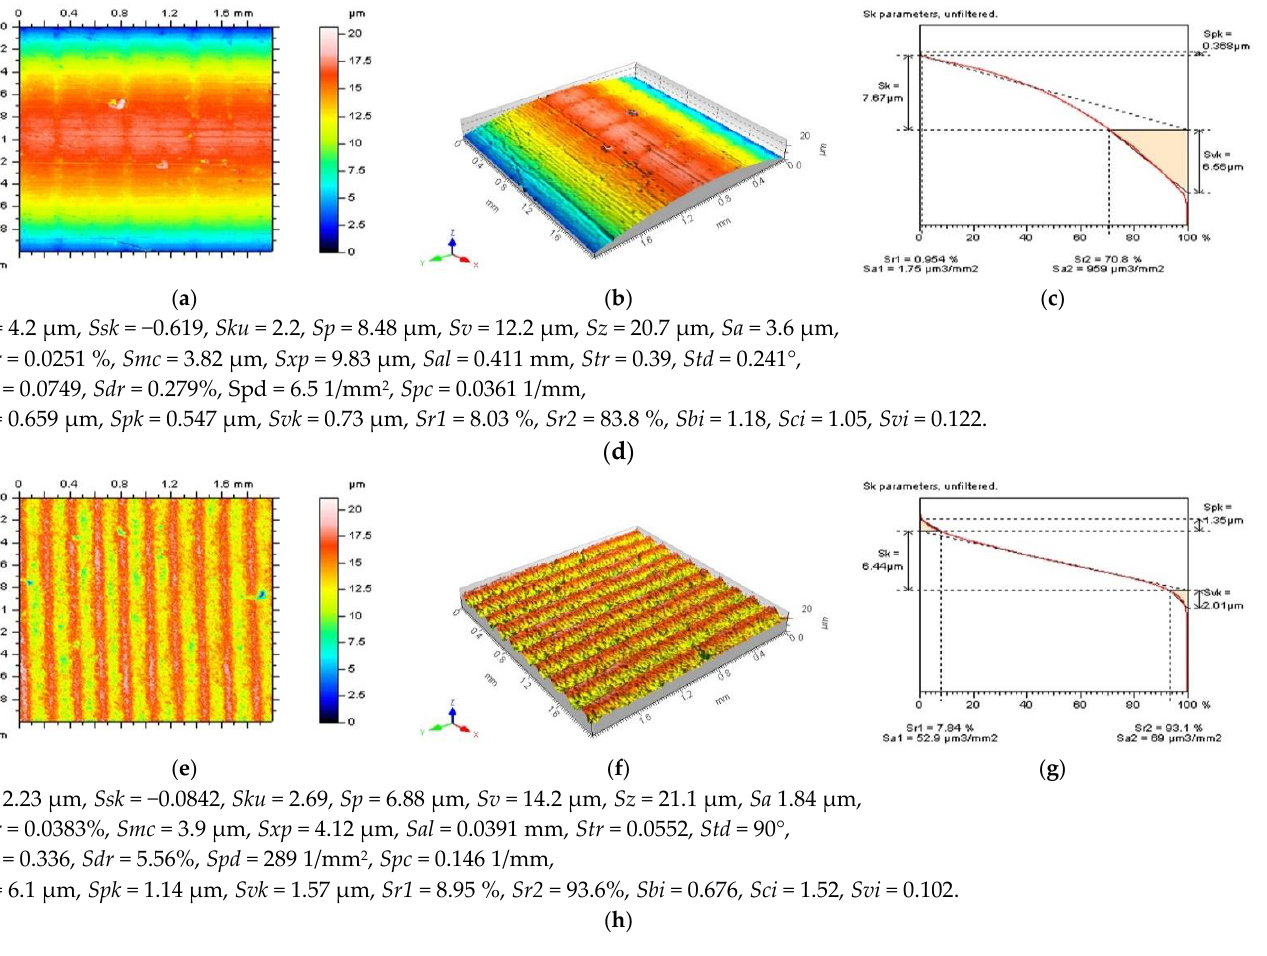
Figure 1. Contour map plots ( a , e ), isometric views ( b , f ), material ratio curves ( c , g ), and ISO 25-178 parameters ( d , h ) of turned surface: measured data ( a – d ) and data after an areal form removal by application of a least square fitted polynomial of 8th degree ( e – h ).